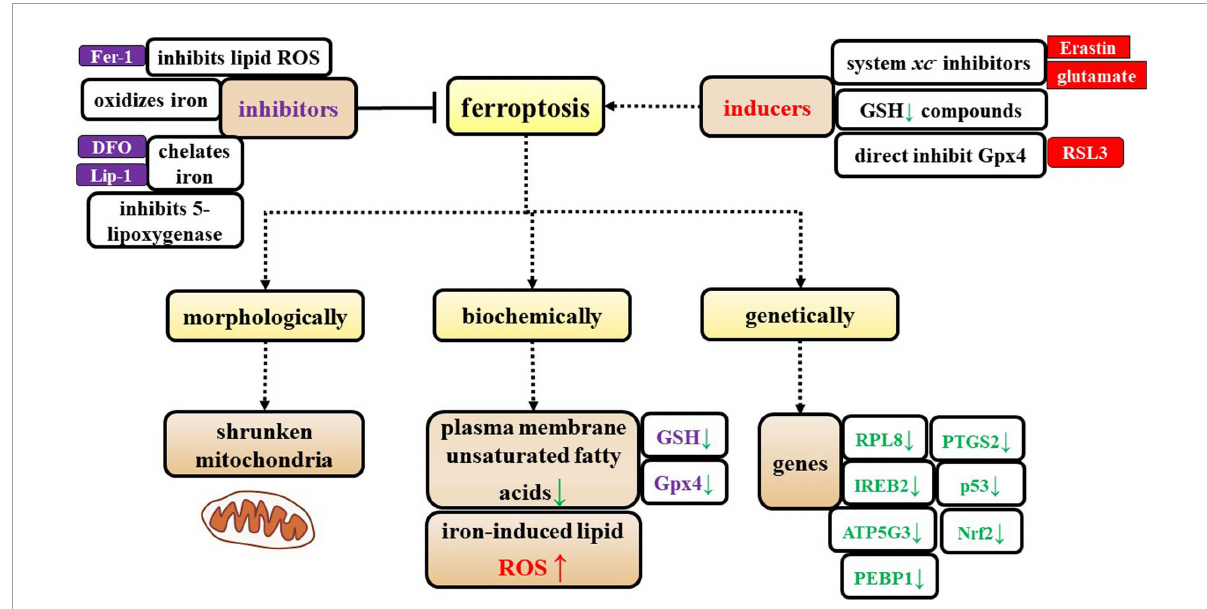
FIGURE1 Characterization of ferroptosis. The specific characteristics of ferroptosis are shown from three perspectives: morphological, biochemical, and genetic alterations. Additionally, the inducers and inhibitors of ferroptosis are shown in this